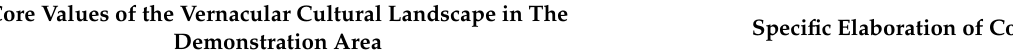
Table 3. Core values of the vernacular cultural landscape in the demonstration area.